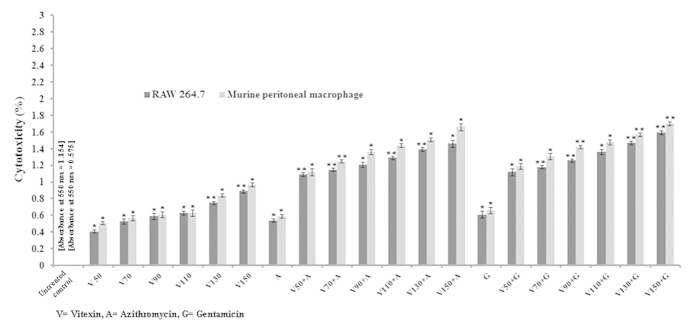
Cytotoxic effect of vitexin alone and in combination against RAW 264.7 murine macrophage cell line and murine peritoneal macrophage.Data are expressed as percentage cytotoxicity with respect to untreated control. Each value is the average of triplicate assay where presented data is mean ± SD. Statistical analysis were done using one way ANOVA and *express P value < 0.01 and **express P value < 0.001 (n = 3).